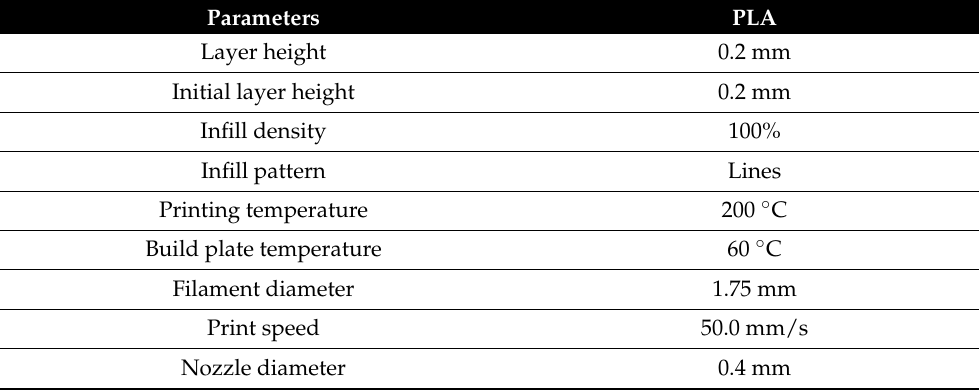
Table 1. Printing parameters for PLA used in the software Ultimaker Cura.